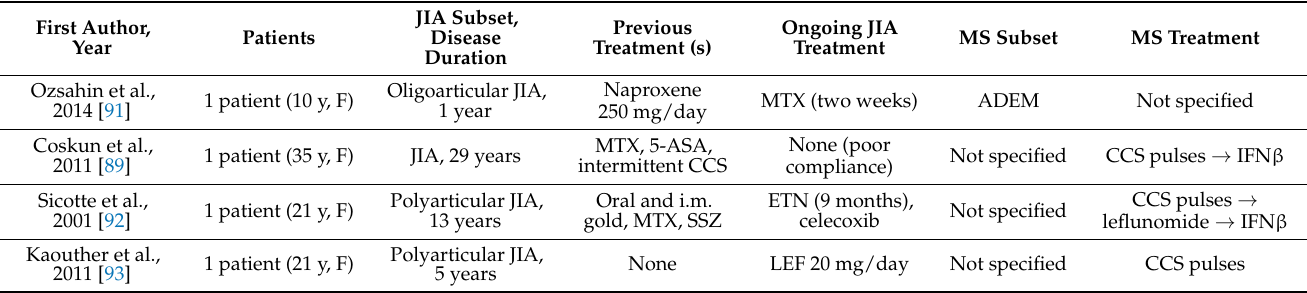
Table 3. Literature findings on concurrence of MS and JIA.